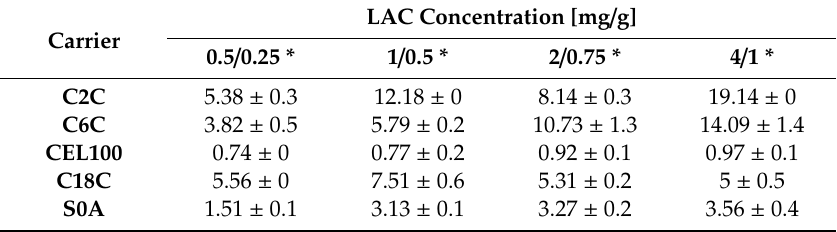
Table 4. E ff ect of the LAC concentration applied for covalent immobilisation (C2C, C6C, CEL100) and via adsorption (C18C, S0A) on the activity of immobilised LAC [U / g]; optimal conditions were: bu ff er pH 7, bu ff er concentration—0.025 M for C2C and 0.1 M for C6C, time and temperature of incubation—3 h and 22 ◦